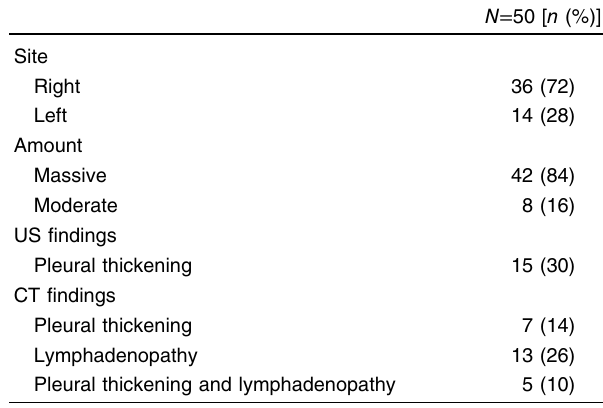
Table 1 Descriptive data of the studied patients Table 2 Radiographic findings